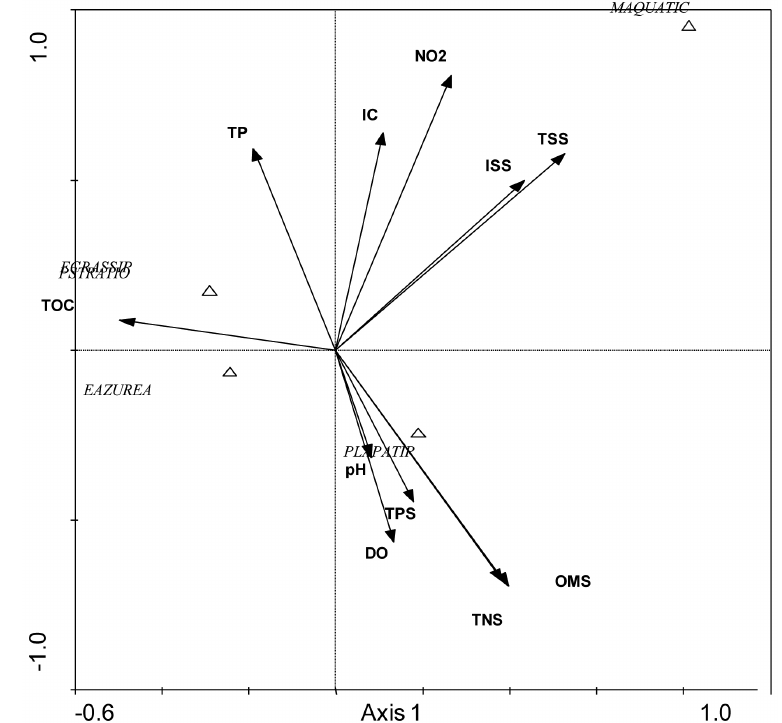
Figure 4. CCA ordination plot on Axis 1 (horizontal) and Axis 2 (vertical) of 5 macropyte species and 11 environ- mental samples. Species codes: EAZUREA: Eichhornia azurea ; ECRASSIP: Eichhornia crassipes ; PSTRATIO: Pistia stratiotes ; MAQUATIC: Myriophyllum aquaticum ; PLAPATIP: Polygonum lapathifolium . Environmental codes: TOC: Total Organic Carbon (mg.L –1 ); TP: Total Phosphorus (mg.L –1 ); IC: Inorganic Carbon (mg.L –1 ); NO